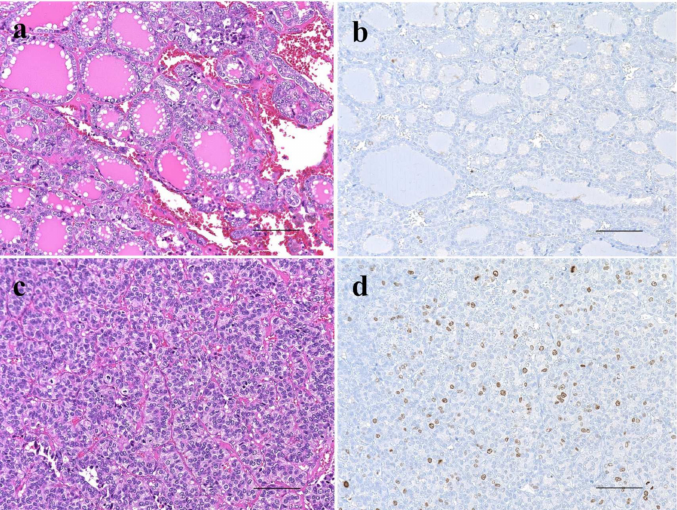
Figure 2. Comparison of histopathology and proliferative activity by immunohistochemistry for Ki-67 expression between outer nodule (Out-N) ( a , b ) and poorly differentiated component (PDc) ( c , d ) in thyroid follicular tumor showing nodule-in-nodule appearance. Out-N shows well-differentiated follicular pattern ( a ) and few Ki-67-positive cells ( b ), whereas PDc shows solid and nestic growth pattern ( c ) and several Ki-67-positive cells ( d ). The scale bars indicate 100 µ